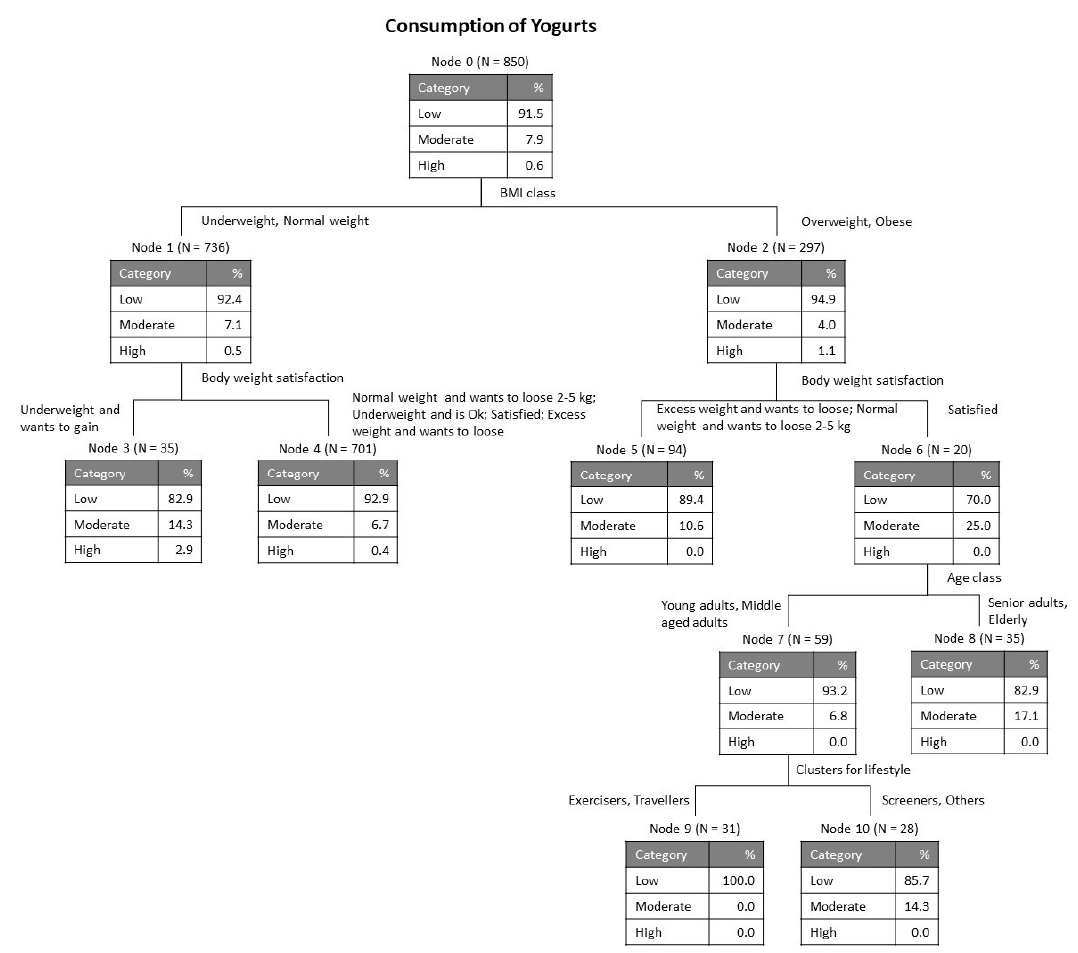
Figure 4. Tree classification for consumption of yogurts.